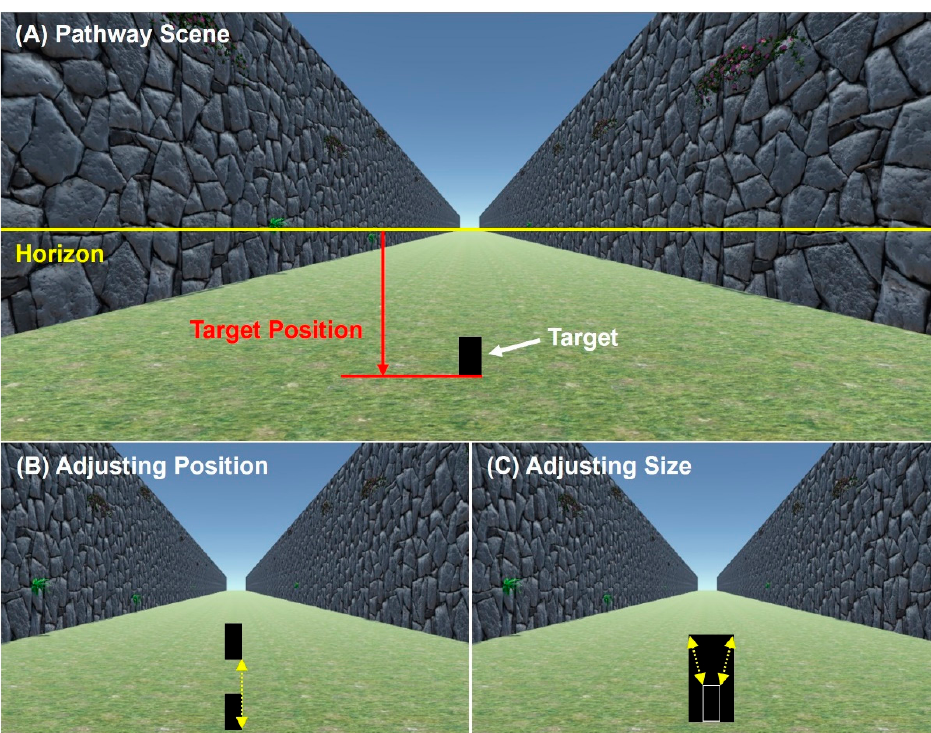
Figure 4. ( A ) The pathway scene with an example of a target (black rectangle) displayed in the scene. The yellow horizontal line is the horizon in the scene—the mid-line of the image. The target position is the distance from the horizon to the target base (red line). Participants were instructed to imagine themselves standing in the pathway looking at their smartphone standing on the ground. ( B ) During